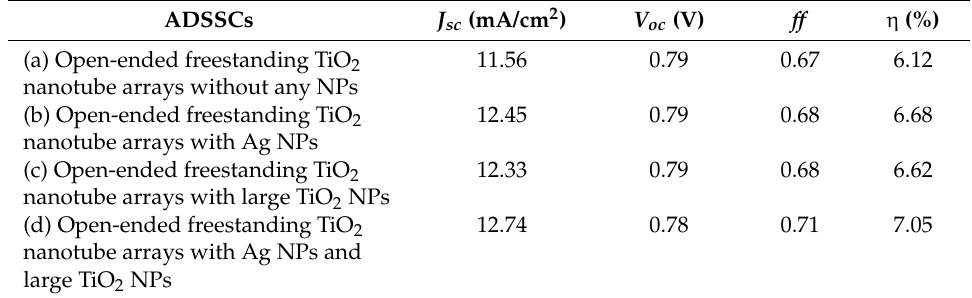
Table 2. Photovoltaic properties of DSSCs based on open-ended freestanding TiO 2 nanotube arrays. ADSSCs J sc (mA/cm 2 ) V oc (V) ff η